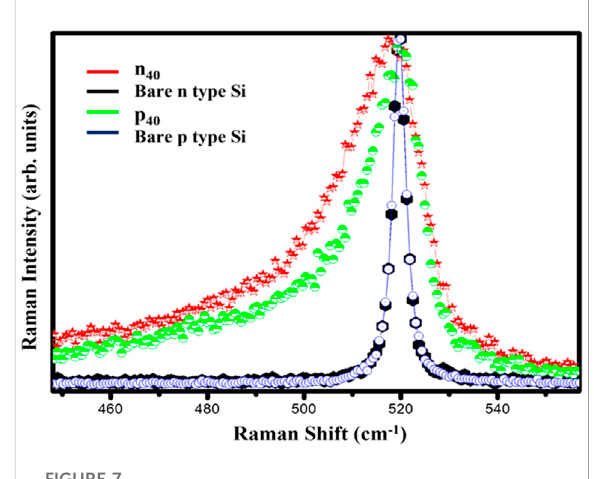
FIGURE 7 Raman analysis for the n 40 and p 40 samples with their bare counterpart.